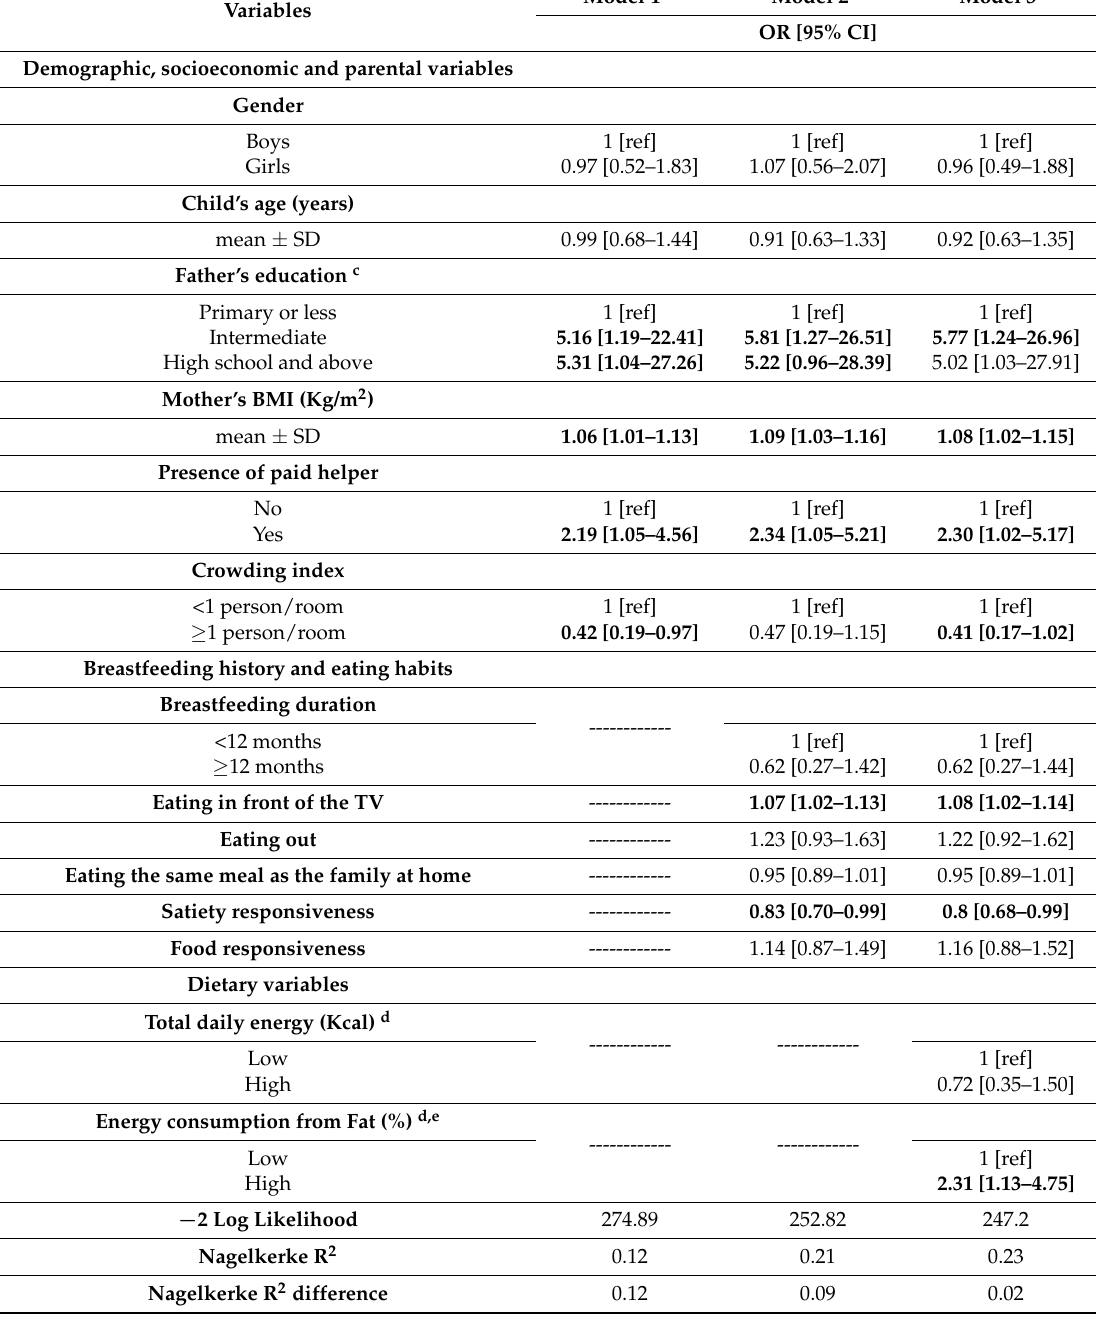
Table 3. Associations of overweight a with selected demographic, socioeconomic, parental, and dietary variables among preschoolers ( n =